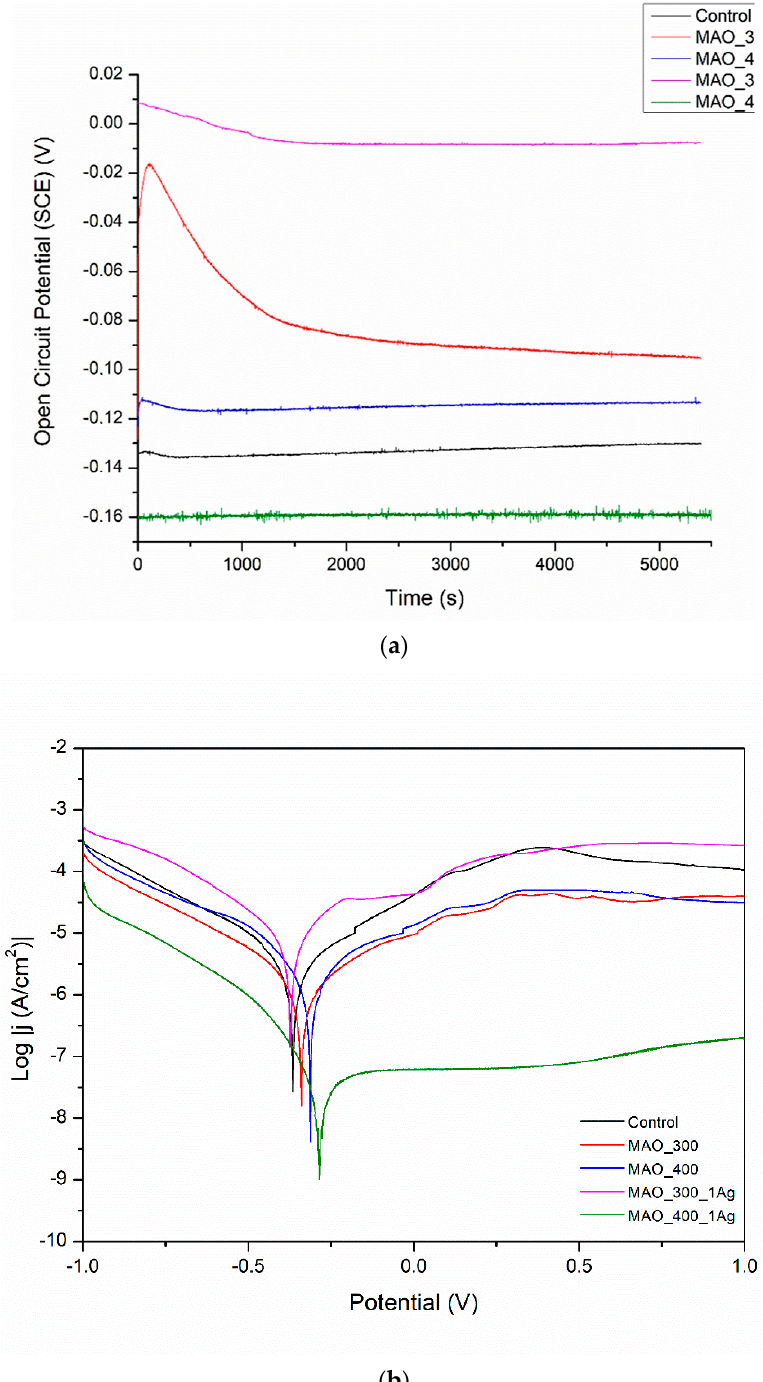
Figure 7. ( a ) Open circuit potential for different modifications, ( b ) potentiodynamic corrosion curves obtained for Ti13Nb13Zr substrate after its surface modifications. Control—ground, MAO_300— ground, and MAO treated at 300 V in CaP + GP solution, MAO_400—ground, and MAO treated at 400 V in CaP + GP solution; MAO_300_1Ag—ground, and MAO treated at 300 V in CaP + GP + Ag, MAO_400_1Ag—solution ground, and MAO treated at 400 V in CaP + GP + Ag solution.